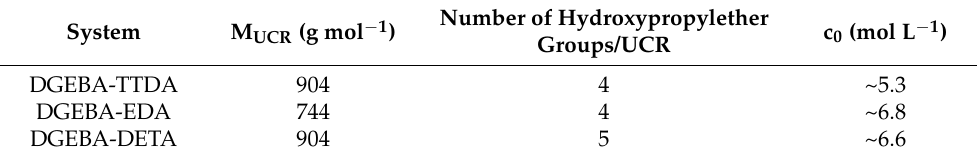
Table 2. Description of repetitive units in model epoxy-amine systems. Number of Hydroxypropylether System M UCR (g mol − 1 ) c 0 (mol L − 1 ) Groups/UCR DGEBA-TTDA 904 4 ~5.3 DGEBA-EDA 744 ~6.8 DGEBA-DETA 904 5